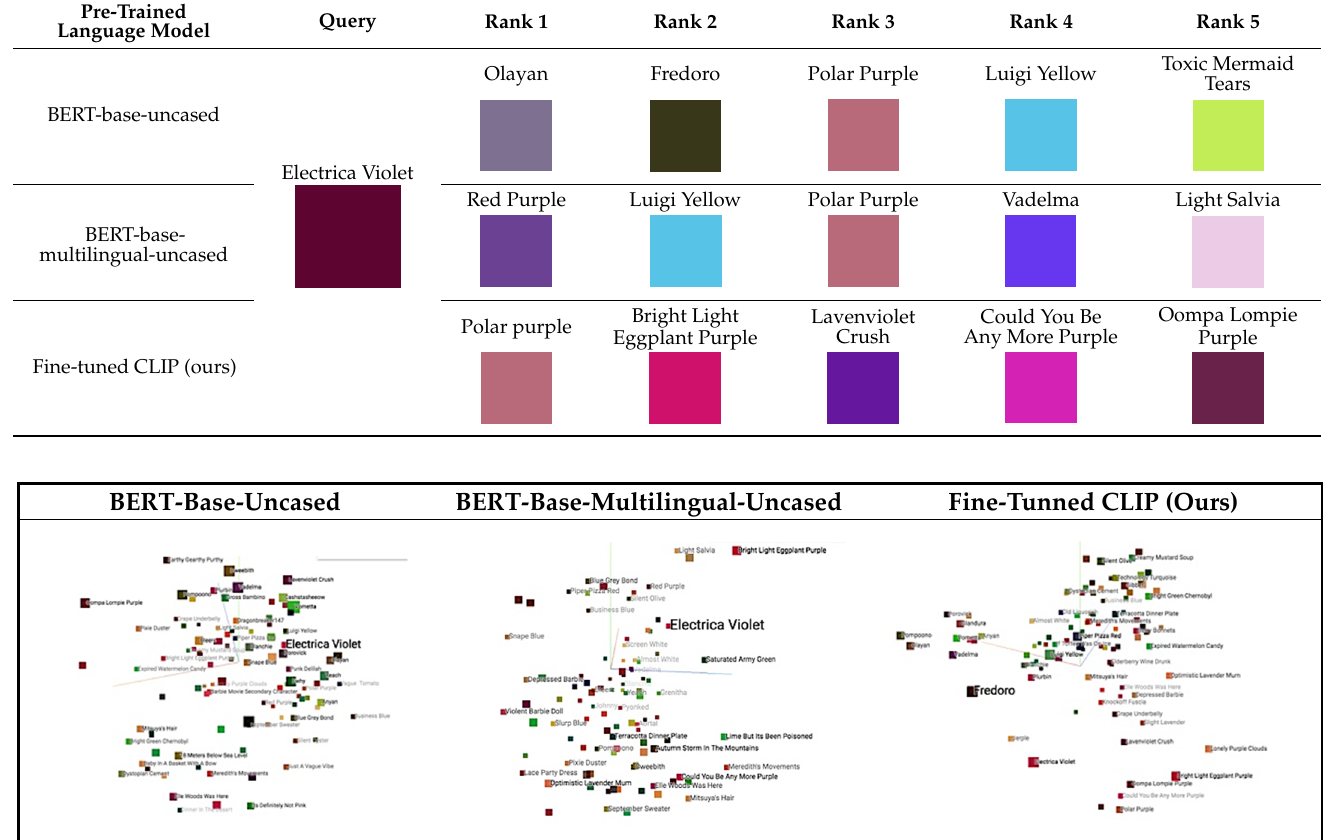
Table 8. Example of color-based similar description retrieval.